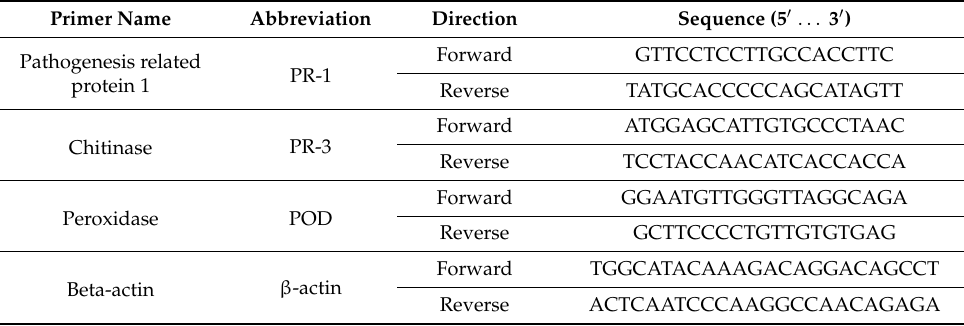
Table 1. Nucleotide sequences of qRT-PCR primers used in this